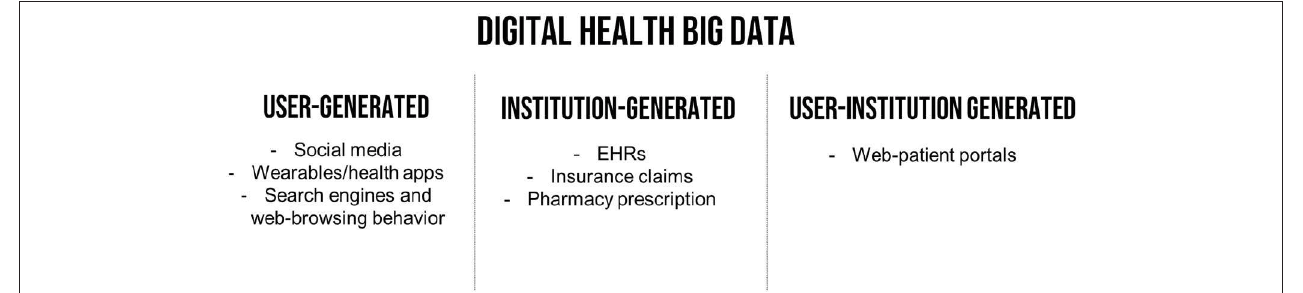
FIGURE 1 | Sources of digital health big data.